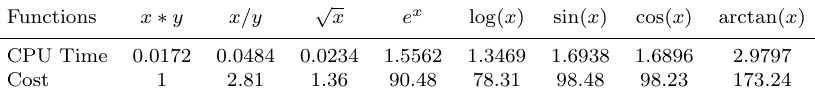
Table 1. CPU time and estimation of computational cost of elementary functions, where √ √ 3 − 1 and y = 5 (with 4096 digits of accuracy). x = √ Functions x ∗ y x/y x e x log( x ) sin( x ) cos( x ) arctan( x ) CPU Time 0.0172 0.0484 0.0234 1.5562 1.3469 1.6938